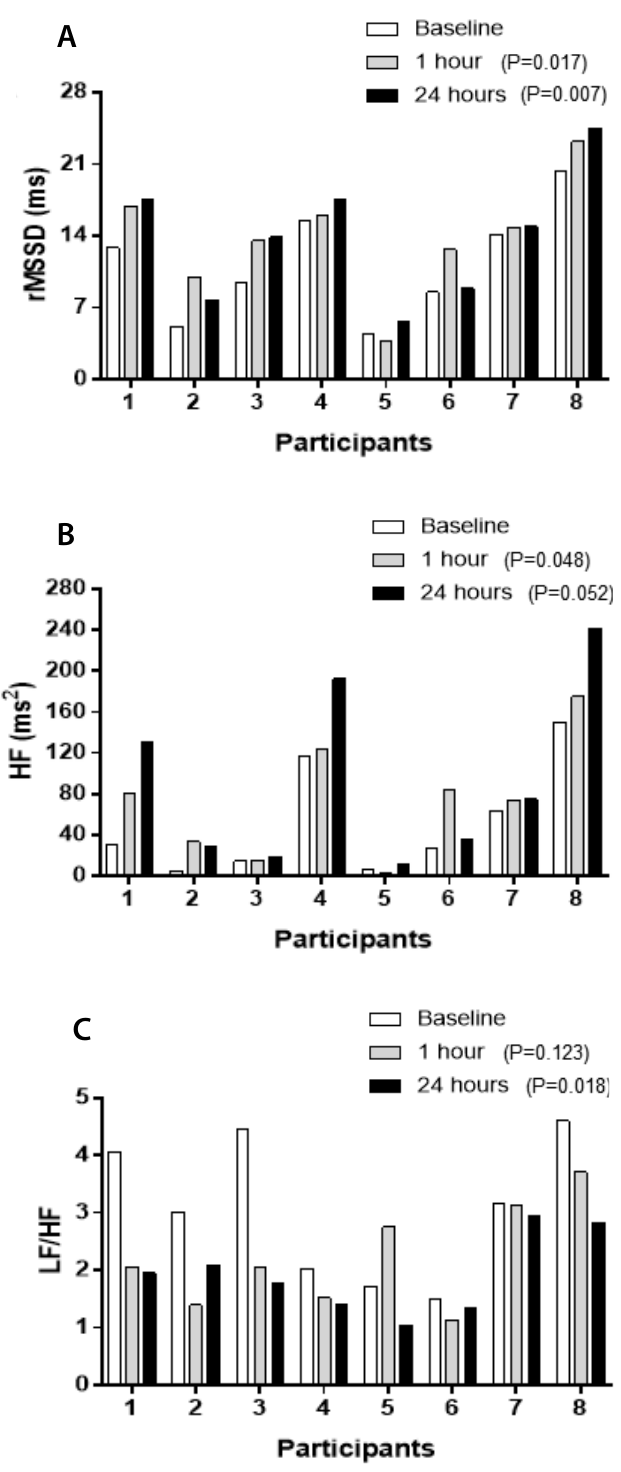
Fig. 1 – Changes in root mean square of successive RR interval differences (rMSSD) (ms), high frequency (HF) (ms 2 ), and low frequency (LF) indexes for each participant before (baseline), after one hour, and after 24 hours of the exercise